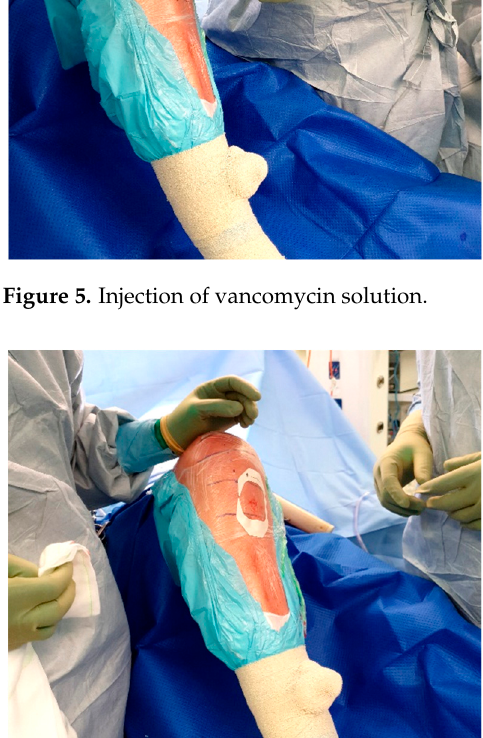
Figure 6. Tegaderm placement.